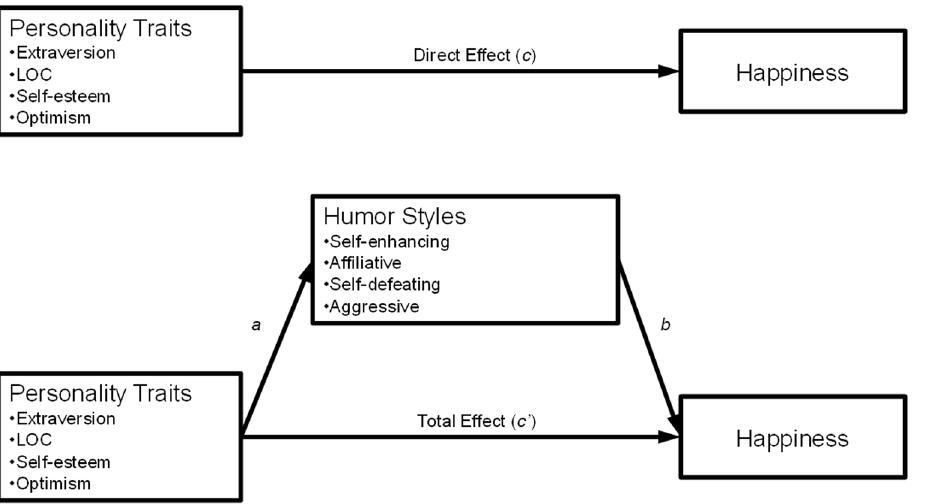
Figure 1. Path Model illustrating our mediation hypotheses including labels for direct and indirect paths. We hypothesized that the relationship between personality traits and happiness is mediated by self-enhancing